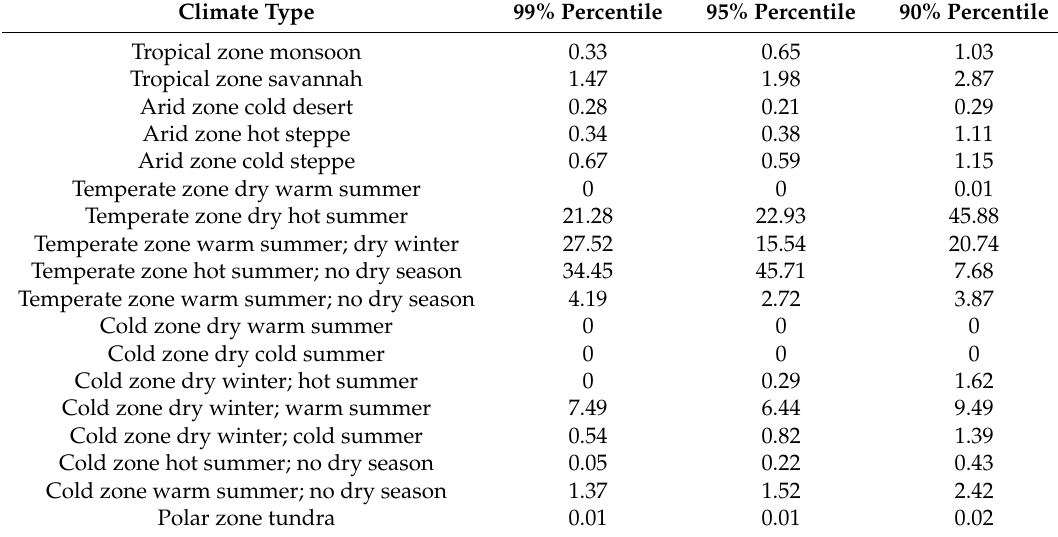
Table 7. Pixel proportion of different climate types at three standard deviation